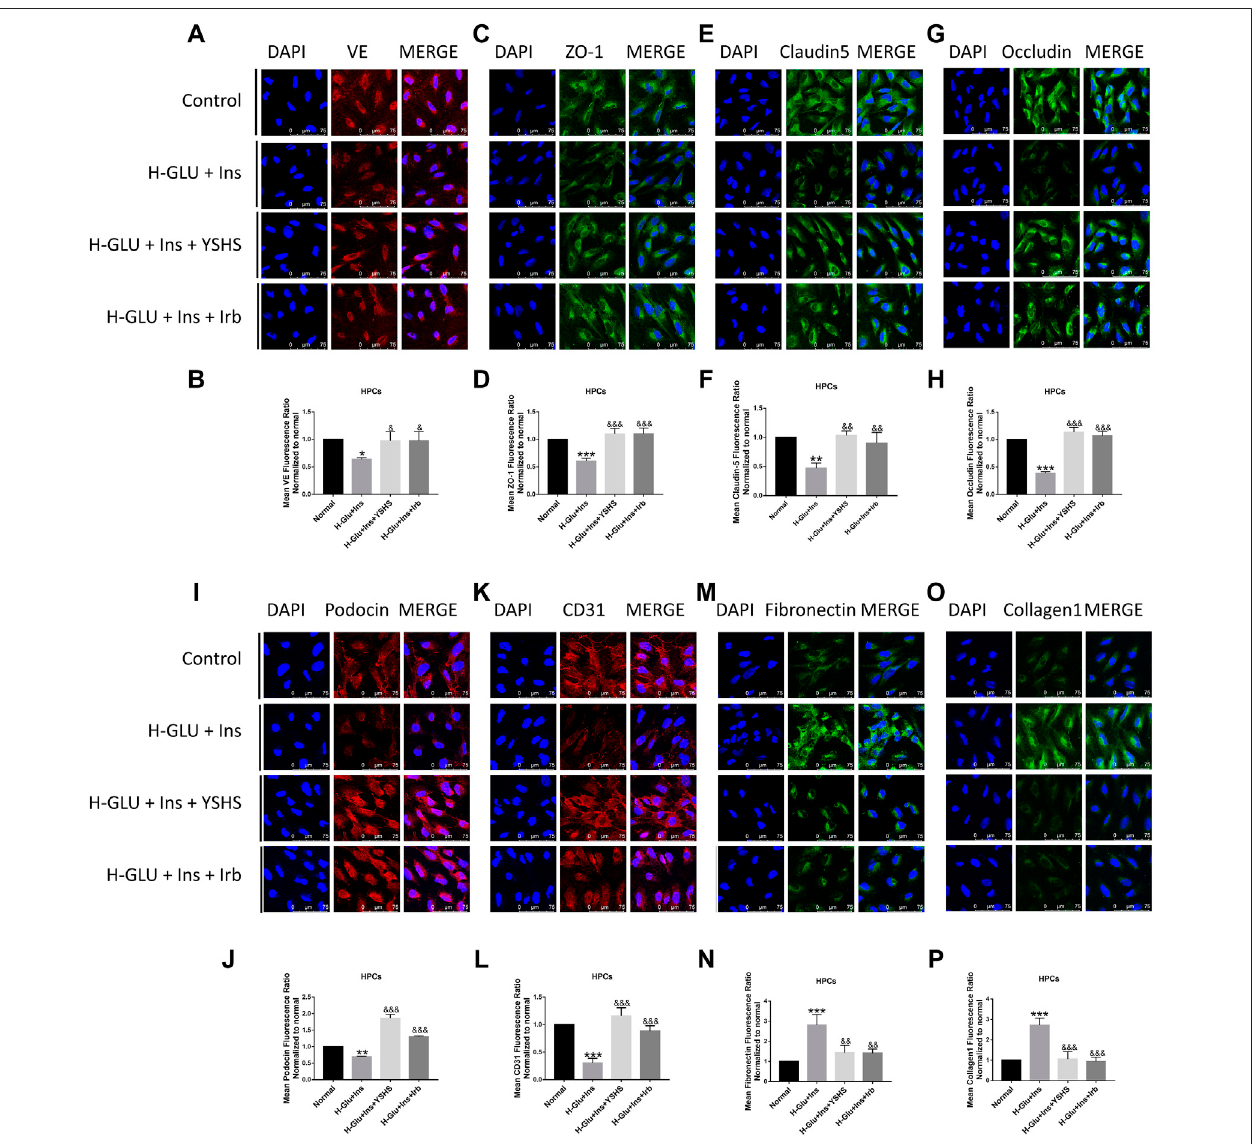
FIGURE 10 | Effect of YSHS on the glomerular fi ltration barrier in HPC cells. Immono fl uorescence assay for HPC tight junction protein VE (A) , ZO-1 (C) , claudin-5 (E) , and occludin (G) under a laser scanning confocal microscope; and relative fl uorescence intensity for them (B,D,F,G) were determined. YSHS increased podocin (I) and CD31 (K) expressions, and relative fl uorescence intensity for them (J,L) were determined. YSHS decreased fi bronectin (M) and collagen1 (O) expressions, and relative fl uorescence intensity for them (N,P) were determined. Values are presented as means ± SEM. * p < 0.05, ** p < 0.01, *** p < 0.001, vs. control; & p < 0.05, && p < 0.01, &&& p < 0.001, vs. H-Glu + Ins.